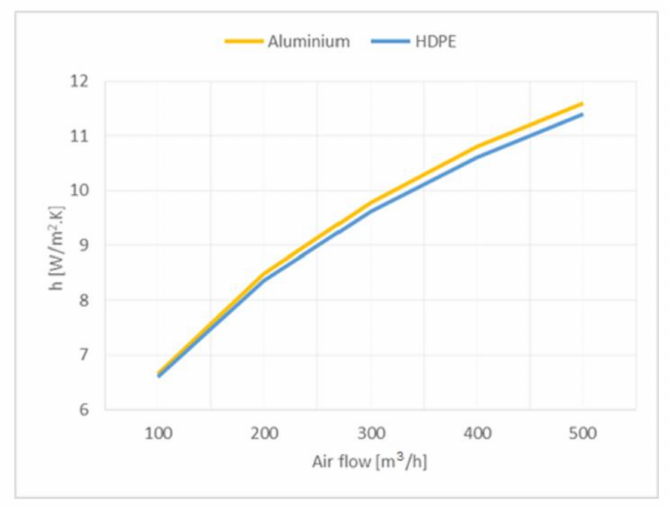
Figure 17. Computed results on the evolution of the heat transfer coefficient for Aluminum and HDPE